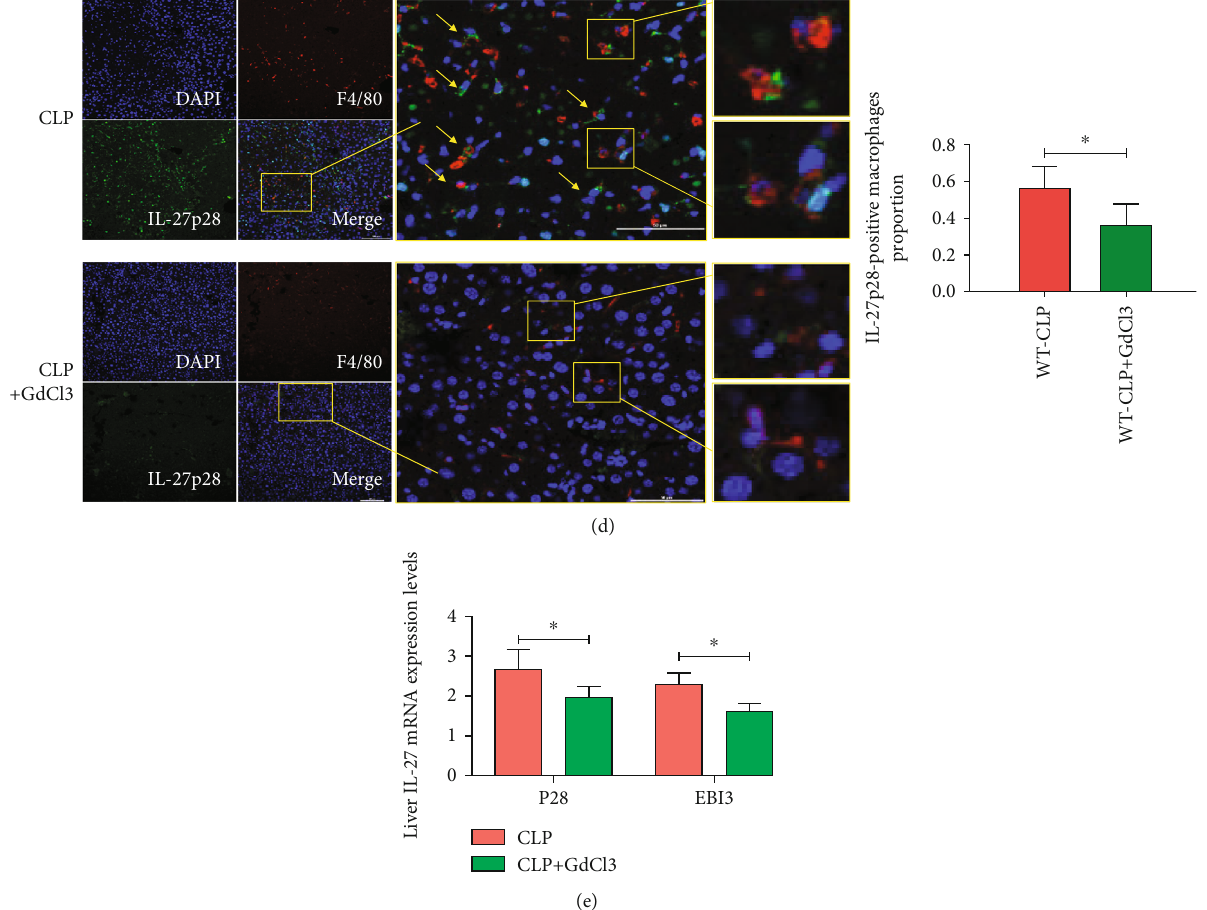
Figure 3: (a) Serum IL-27, IL-6, TNF- α , and IL-1 β levels (by ELISA) of WT mice after CLP with or without GdCl3 pretreatment, NS: p > 0 : 05 . (b) Hematoxylin and eosin- (H&E-) stained lung and kidney tissues and histological scores from sham WT mice (Sham) and WT mice after CLP ( n = 5 per group) with or without GdCl3 pretreatment ( × 200, × 400 magni fi cations), ∗∗ p < 0 : 01 , NS: p > 0 : 05 . (c) M1 and M2 polarization numbers of liver macrophages in sham WT mice (sham) and WT mice after CLP ( n = 5 per group) with or without GdCl3 and recombinant IL-27 (R IL-27) pretreatment (by immuno fl uorescence) ( × 200, × 800 magni fi cations). Blue fl uorescence stands for DAPI, red fl uorescence stands for F4/80, green fl uorescence stands for CD206, and pink fl uorescence stands for iNOS. The F4/80+iNOS image showed only the M1 type macrophages (cells with red and pink color), while the F4/80+CD206 image showed only the M2 type macrophages (cells with red and green color), and the merged image showed both the M1 type and M2 type of macrophage. ① stands for M1 type macrophages, ② stands for M2 type macrophages, and ③ stands for macrophages that are not polarized to M1 or M2 type. ∗ p < 0 : 05 , ∗∗ p < 0 : 01 , NS: p > 0 : 05 . (d) The IL-27p28 expression in liver macrophages after CLP ( n = 5 per group) with or without GdCl3 pretreatment (by immuno fl uorescence) (confocal microscopy × 200, × 600 magni fi cations). Blue fl uorescence stands for DAPI, red fl uorescence stands for F4/80, and green fl uorescence stands for IL-27p28. ∗ p < 0 : 05 . (e) EBI3 and P28 mRNA levels of liver macrophages in WT-CLP and WT- CLP+GdCl3 mice groups (by qPCR), ∗ p < 0 : 05